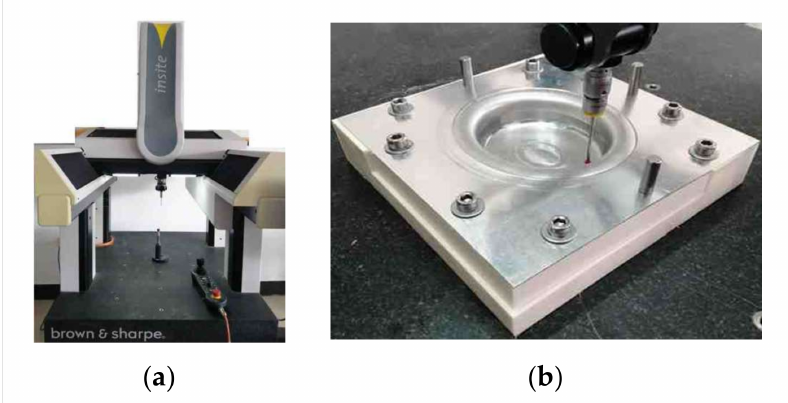
Figure 35. Profile measurement: ( a ) the three-coordinate measuring instrument; ( b ) measure- ment